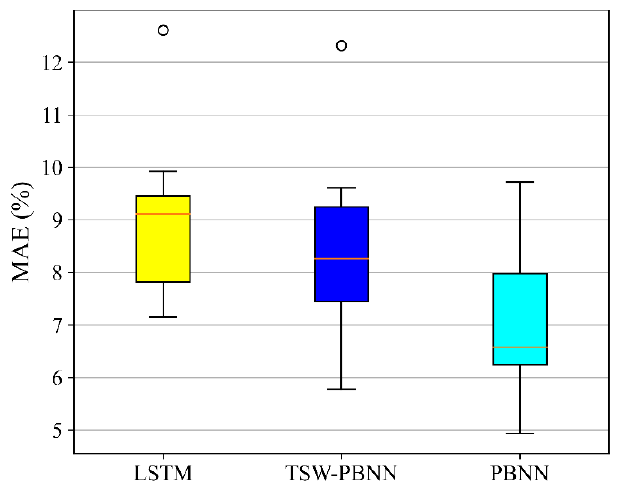
Figure 13. MAE boxplot for LSTM, TSW-PBNN, and